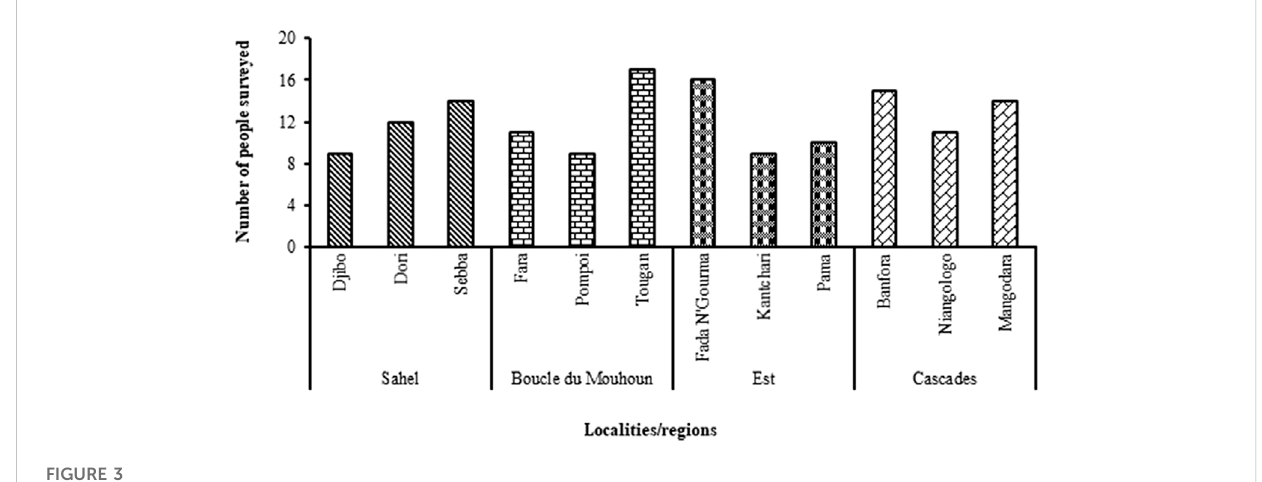
FIGURE 3 Number of people surveyed by area.